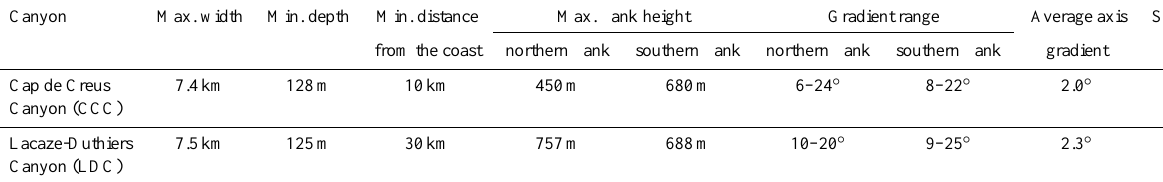
Table 1. Main morphological characteristics of the Cap de Creus and Lacaze-Duthiers submarine canyon heads. Canyon Max. width Min. depth